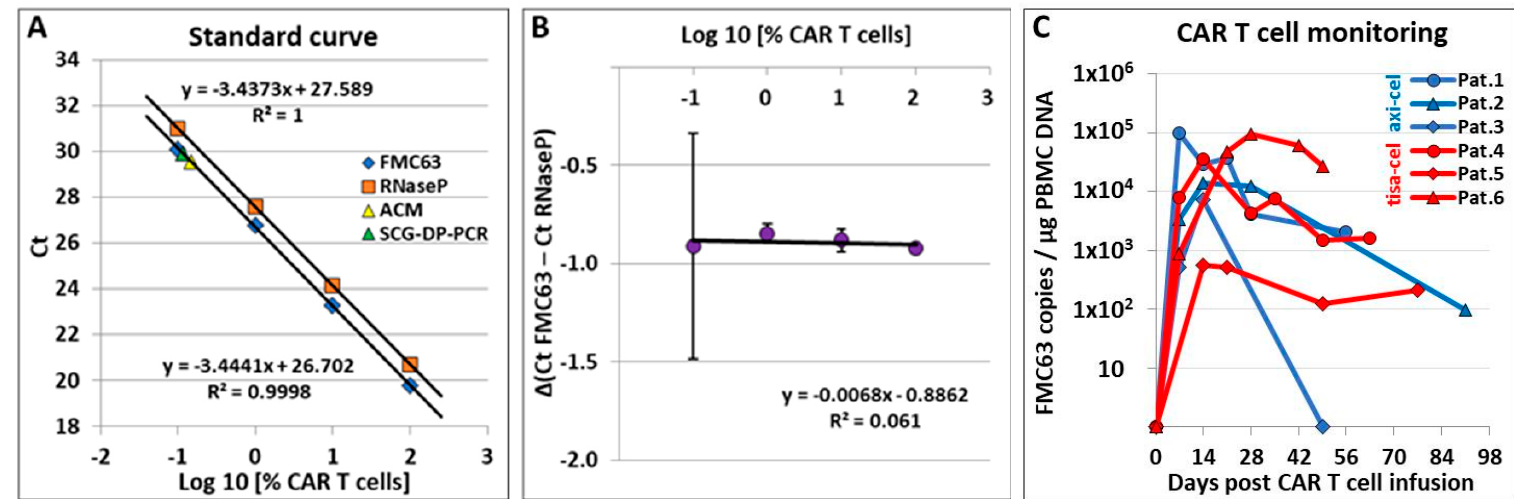
Figure 1. ( A ) Standard curves of duplex qPCR reactions targeting FMC63 and ribonuclease P (RNaseP) (semi-logarithmic display; X-axis: % chimeric antigen receptor T cells (CARTs) (log10); y-axis: threshold cycle (Ct)) and exemplary data from one validation experiment are displayed. Data points assessed via absolute standard curve method (ACM) and single copy gene-based duplex-PCR (SCG-DP-PCR) were included into the graph. Mean Ct values from qPCR were used for linear regression. Reactions were performed in triplicates. QPCR: quantitative polymerase chain reaction; Ct, threshold cycle. ( B ) The relative efficiency plot compares simultaneous PCR reactions over the tested Ct range by calculation of Δ (Ct FMC63 – Ct RNaseP) and the use of graphical analysis (semi- logarithmic display; X-axis: % CARTs (log10); Y-axis: Δ Ct). Exemplary data from one validation experiment are shown. Mean Ct values from qPCR were used for Δ Ct calculations. Results are